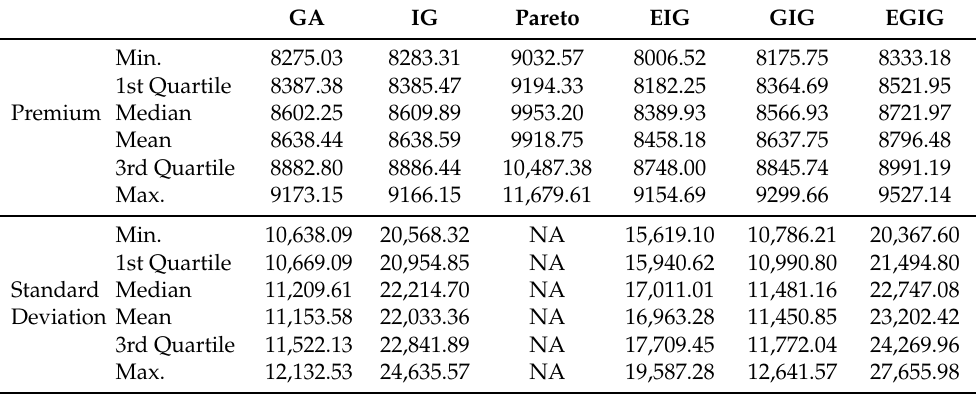
Table 3. Summary of calculated premium and standard